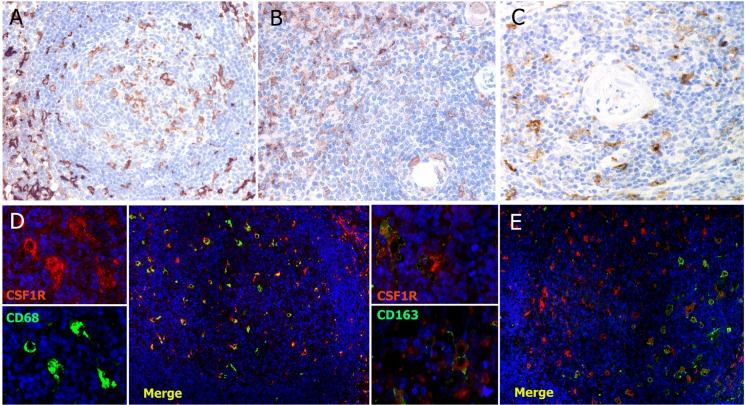
Immunohistochemical expression of CSF1R protein in normal lymphoid tissues.CSF1R+ macrophages (brown) are abundant in the paracortex of the lymph nodes (A), the red pulp of the spleen (B), and the medulla of the thymus (C). Panels D-E, double immunofluorescence experiments in tonsil: CSF1R (red) and CD68 (green) (D) and CSF1R (red) and CD163 (green) (E). It can be seen that while CSFR1+ cells also express CD68 (D), CD163 is limited to only a subpopulation of CSFR1+ cells (E).